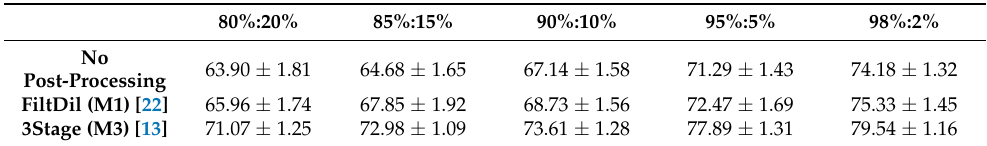
Table 8. Mean average precision mAP (%) of ten sample frames when post-processed by FiltDil (M1) vs. 3Stage scheme (M3) after applying updated two-stage learning (FC-DenseNet 103).